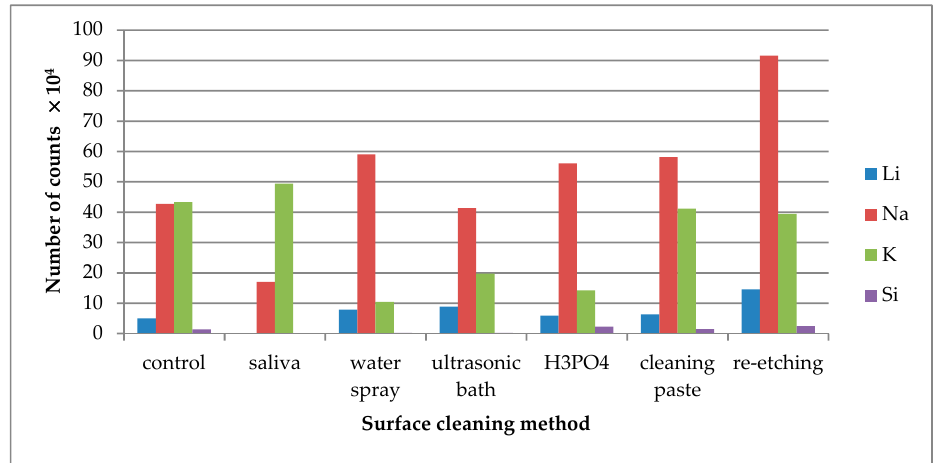
Figure 2. Number of counts of positive ions emitted from the surface of leucite glass ceramic (LGC) after various surface cleaning methods.